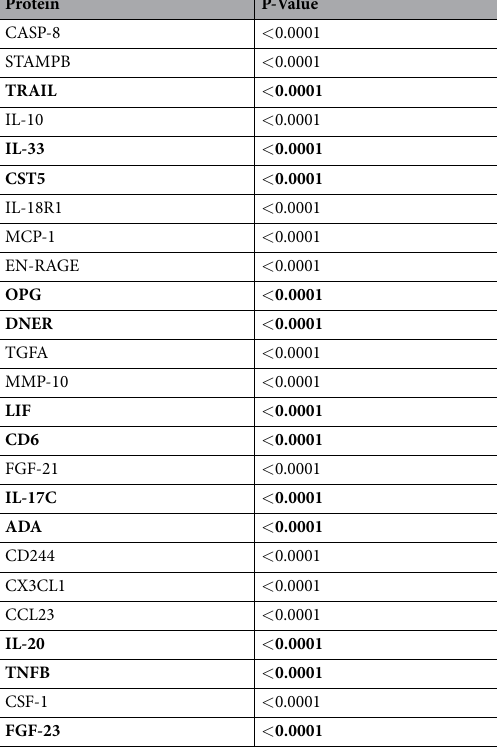
Table 1. Inflammatory proteins differentially expressed over time for each injury group. Proteins exclusively found to differ between time points are shown for each group; EC ( in bold ), mTBI + EC ( in bold ) and sTBI + EC ( in bold ). ANOVA with Bonferroni correction to show differences within each group between time points ( p < 0.00057